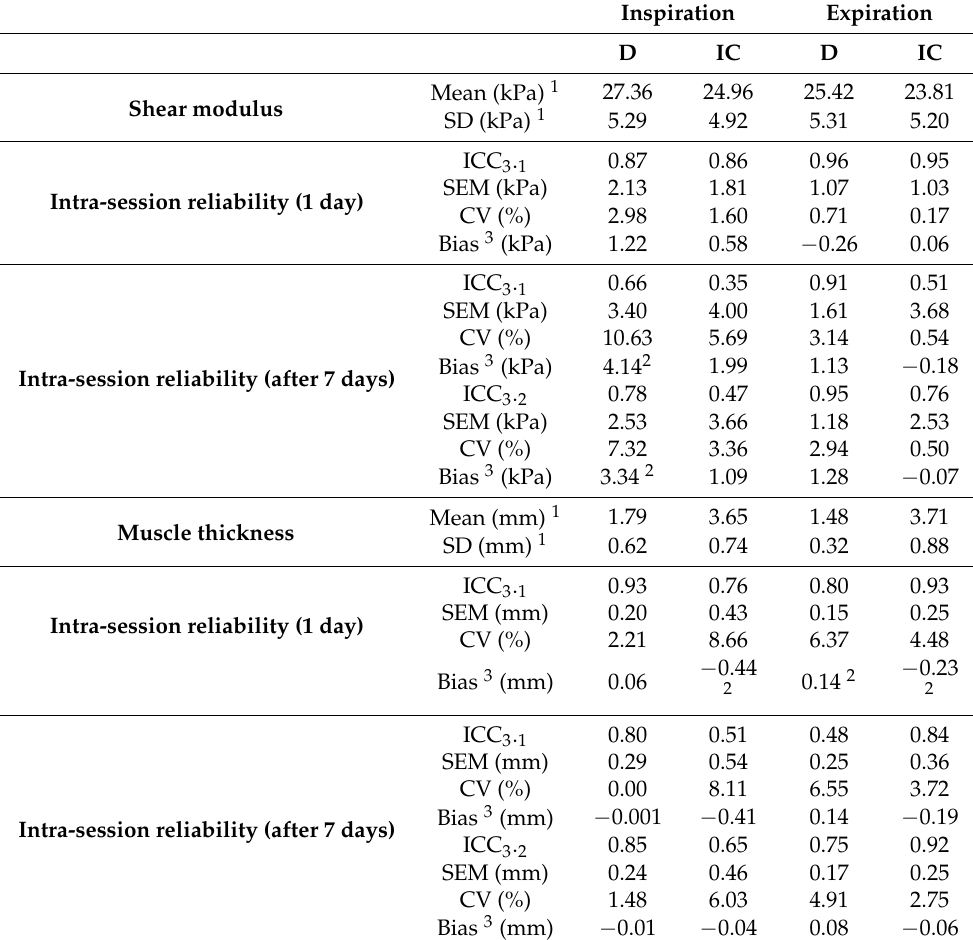
Table 1. Reliability and validity of stiffness and thickness values measured in diaphragm (D) and intercostal (IC) muscles in transverse probe